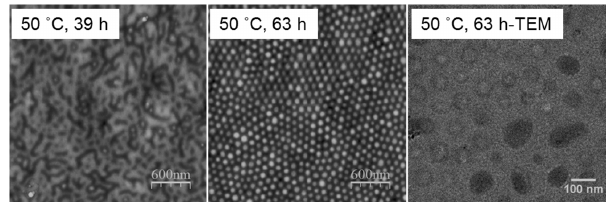
Figure 5. AFM height profiles and TEM images of the 80-nm PS- b -P2VP thin films spin-coated at 2500 rpm from 1.5 wt % solution in toluene with further annealing in toluene vapor atmosphere at 60 °C with different annealing times.